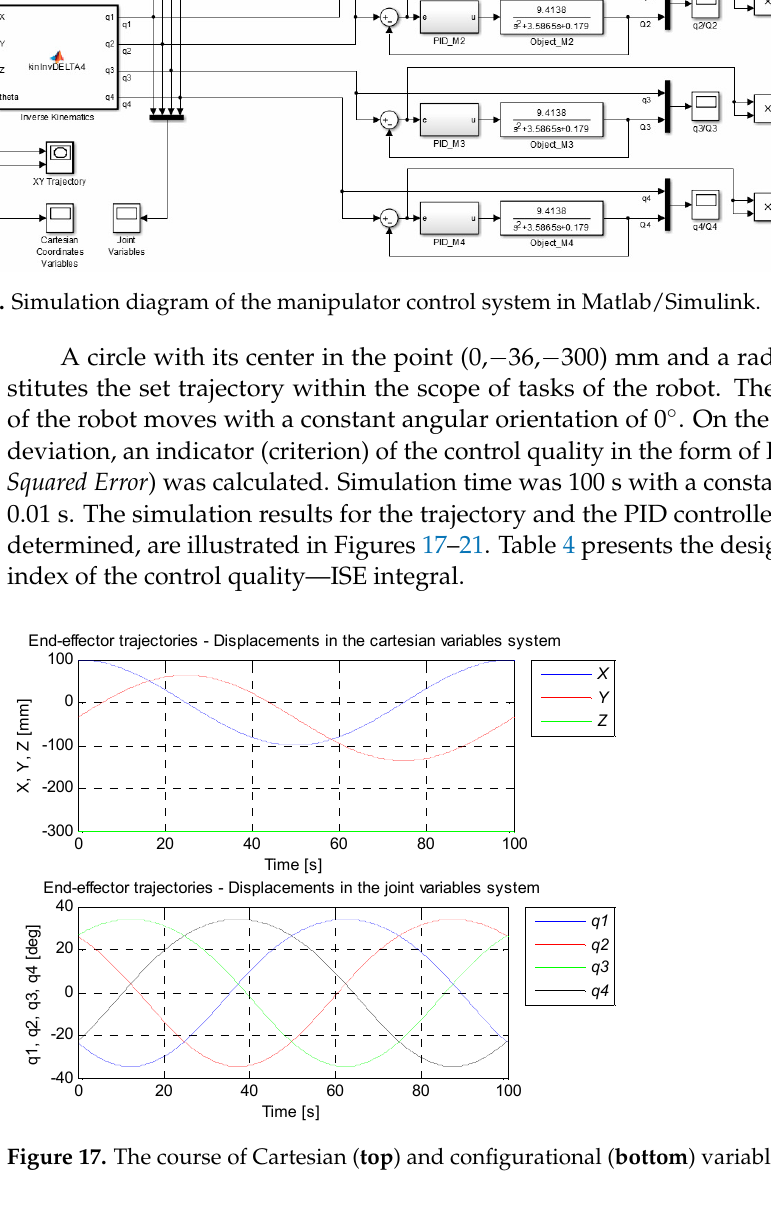
Figure 17. The course of Cartesian ( top ) and configurational ( bottom ) variables for the given track.